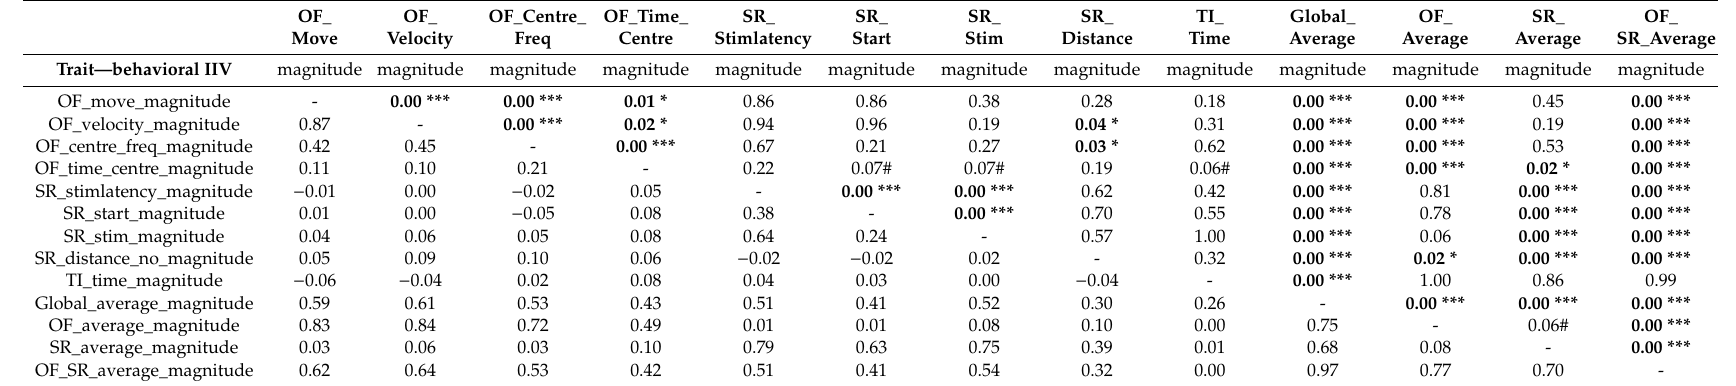
Table 1. Intra-individual behavioural variability